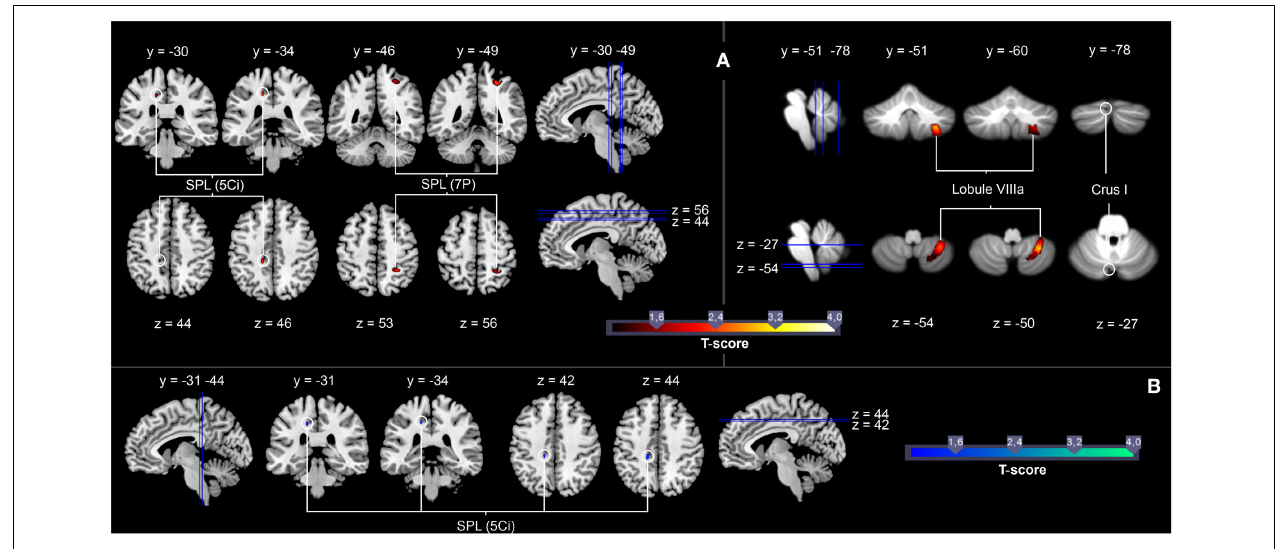
FIGURE 4 | (A) Brain areas showing significantly stronger activation as a function of the number of correct responses for the contrast Tennis and Volleyball Anticipation > Tennis and Volleyball Observation in all 31 participants (red marks). (B) Brain areas showing significantly stronger activation as a function of the number of correct responses in serve